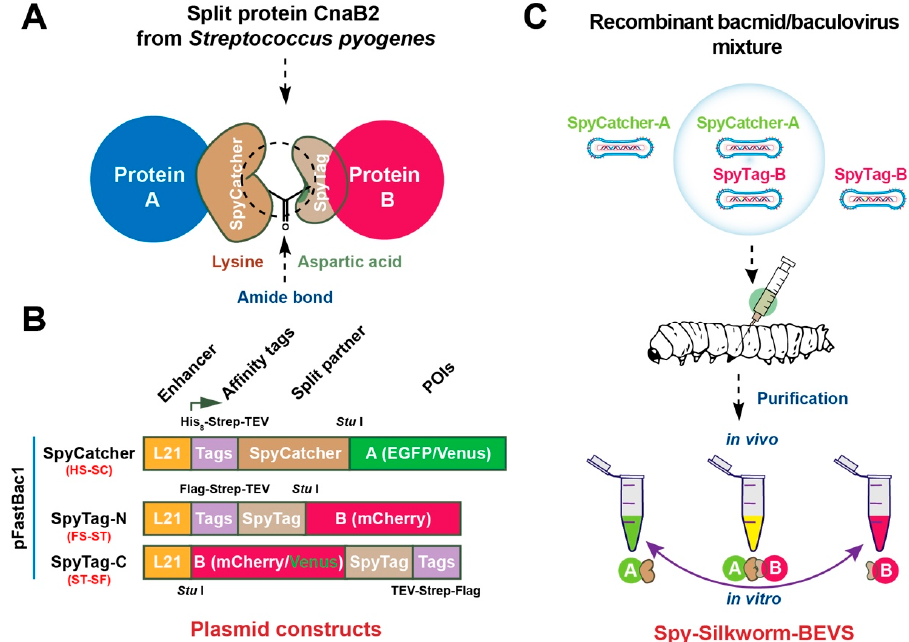
Figure 1. Schematic design of SpyTag/SpyCatcher-Bacmid/Baculovirus expression vector system (SpyBEVS). ( A ) Lysin-Aspartic acid amide bond formation between SpyTag/SpyCatcher-fused (ST/SC) partners. ( B ) Expression (pFastBac1) constructions of SpyCatcher and SpyTag (N/C-terminus). L21, a 5 ′ untranslated leader sequence (21 bp) from a lobster tropomyosin cDNA as an enhancer to improve the protein expression level in BEVS [31]; His 8 , 8 × histidine tag; Strep, Strep-tag; TEV, a recognition site of TEV protease; FLAG, DYKDDDDK-tag. GGGS linker is